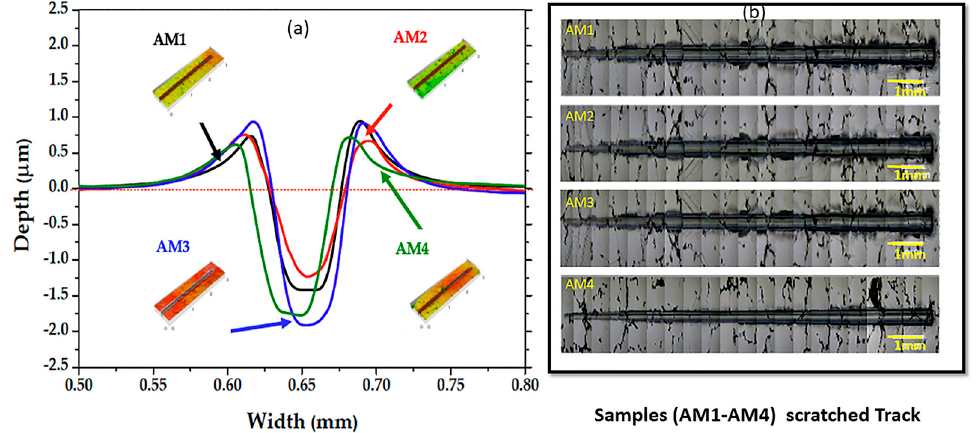
Figure 13. ( a ) Mean profile cross-section widths, as a function of depth, obtained via 3D optical profilometry. ( b ) Images showing the experimental results for the ramp-load scratch testing of Co-Cr-Mo samples AM1-AM4.